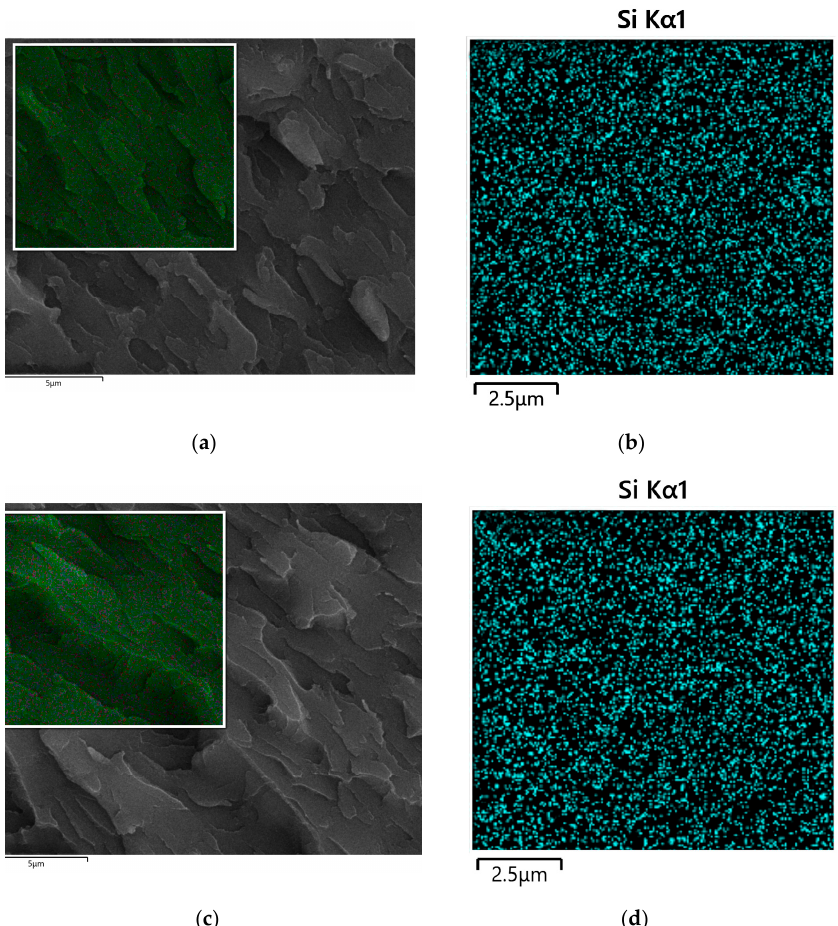
Figure 12. SEM and Si-mapping of BZ/DDSQ-EP composites: ( a ) The SEM of BZ/DDSQ-EP (1 wt.%), ( b ) The Si mapping of BZ/DDSQ-EP (1 wt.%), ( c ) The SEM of BZ/DDSQ-EP (2 wt.%), ( d ) The Si-mapping of BZ/DDSQ-EP (2 wt.%).